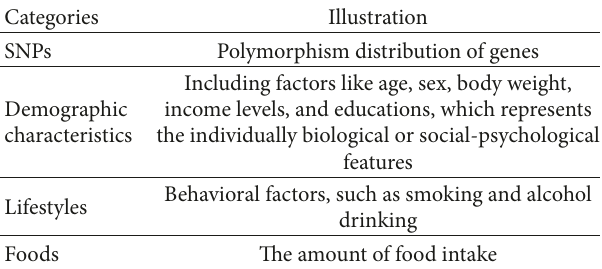
Table 4: The results by relief